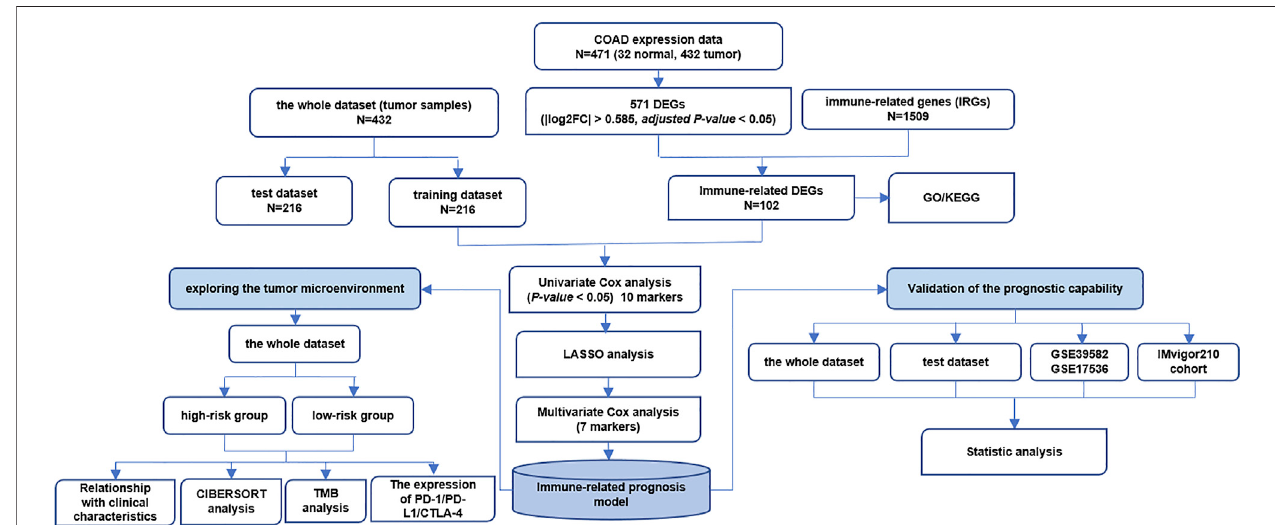
FIGURE 1 | The whole fl ow chart of data